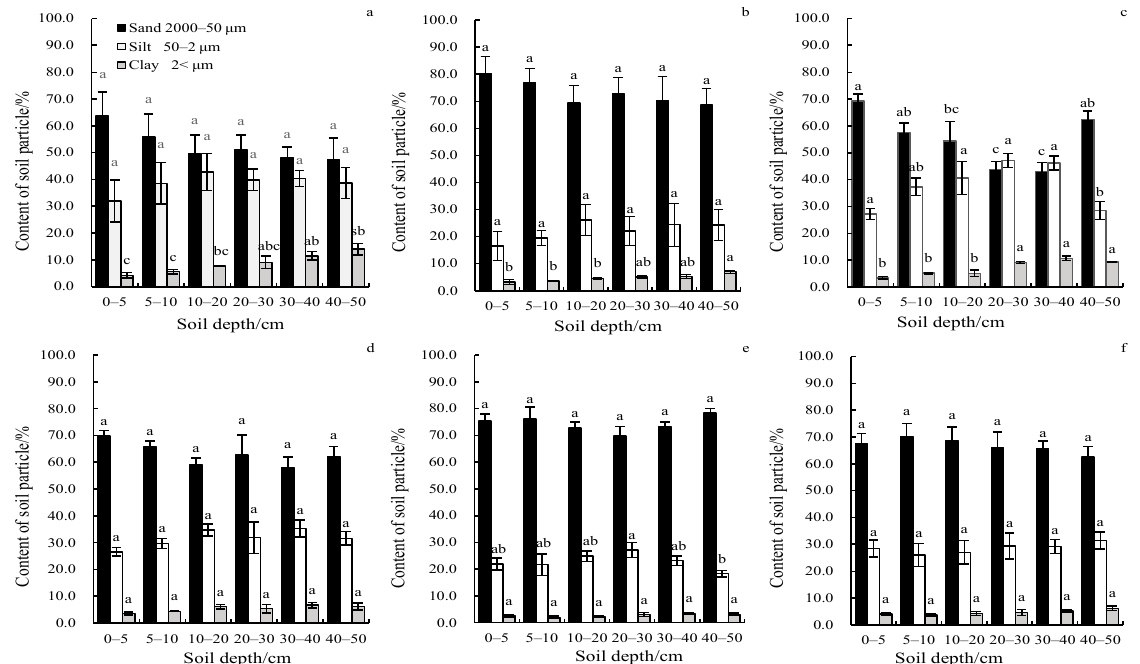
Figure 3. Distribution of soil particles in grasslands in different restoration years (( a – f ) in the figure represent restoration 4a, 5a, 6a, 7a, 8a, and 9a, respectively, the same as below). Notes: The lowercase letters in the figures represent significant differences in the same component at different depths ( p < 0.05).